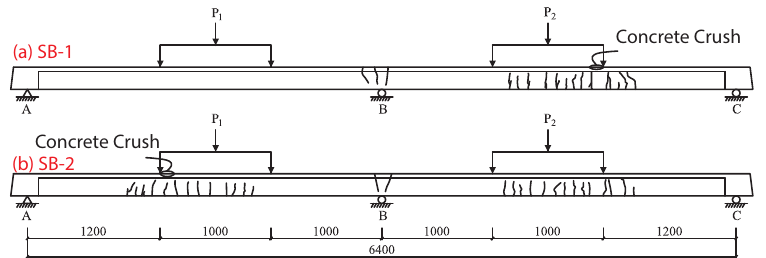
Figure 3. Distribution ofc oncrete cracks in continuous beam: ( a ) SB-1, ( b )